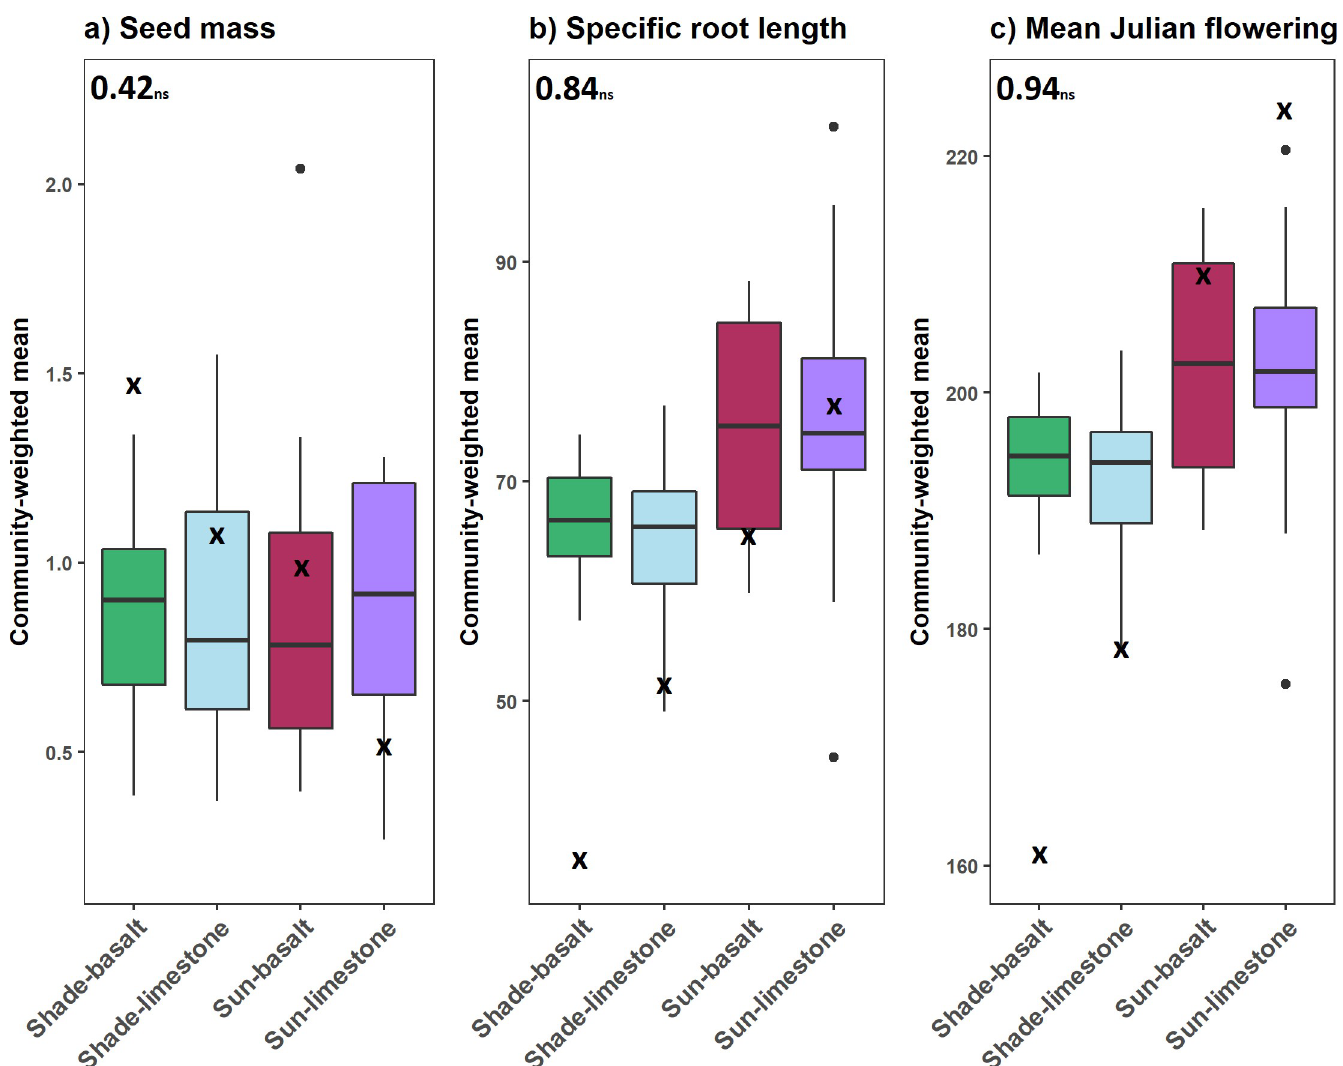
Fig 2. Distribution of observed (boxplots) and predicted ( x ) CWM trait values for a) Seed mass, b) Specific root length, and c) Mean Julian flowering date in four treatments based on light level and parent material; shade-basalt (green), shade-limestone (red), sun-basalt (blue), and sun-limestone (purple). Pearson’s correlation coefficients are given. No significant (ns) correlations between observed and predicted CWM trait values were